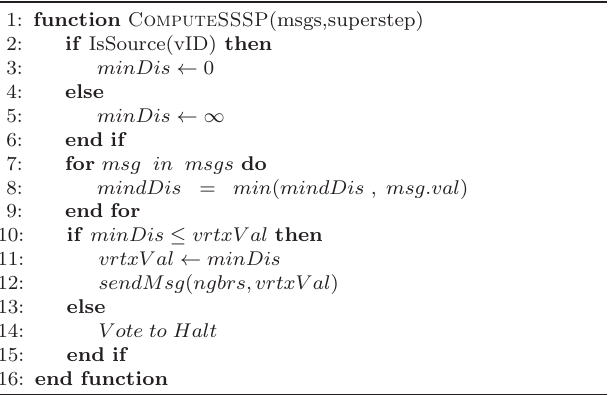
Algorithm 2 Vertex-Centric Implementation of SSSP